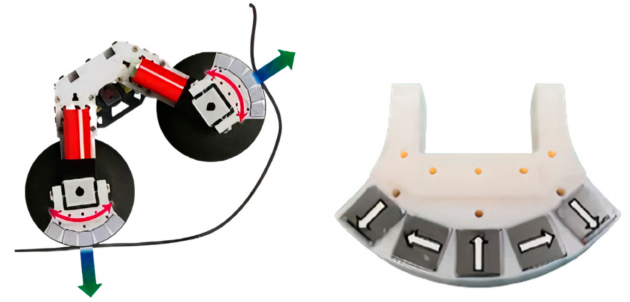
Figure 5. Wheel construction with Halbach-Array